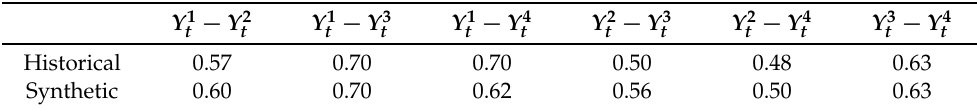
Table 7. Comparison of historical and simulated rank